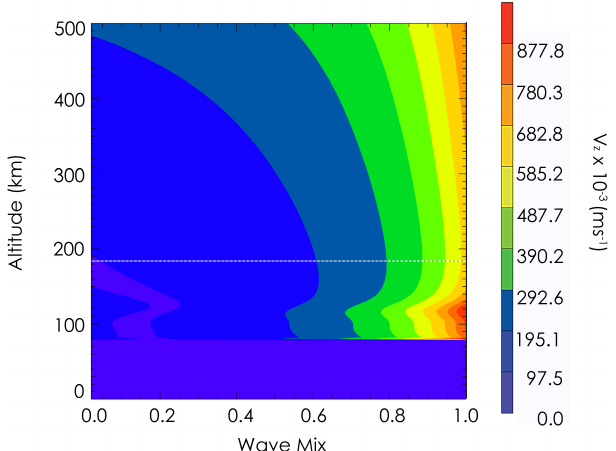
Fig. 10. The plot shows V z as a function of both altitude and wave mode mix. The overplotted white dot-dashed line highlights the DOPE reflection altitude at roughly